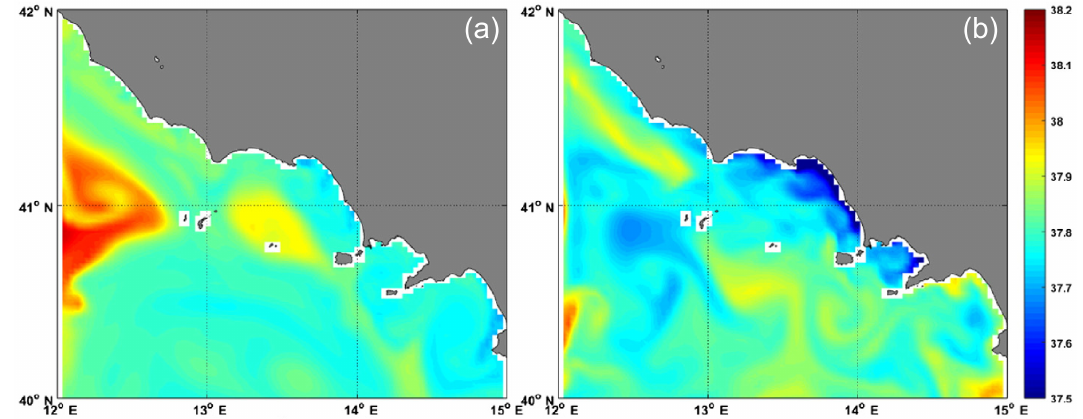
Figure 15. Surface salinity field (daily average) corresponding to 14 November 2010 without assimilation (a) and after assimilation (b) . From Fig. 1 in Santoki et al. (2013). Table 1. Summary of characteristics for the different methods. The latency of altimetric maps is taken to be 3 days, which corresponds to the intermediate map generated by SSALTO/DUACS system although preliminary data is available within 12h (AVISO Altimetry, 2016). The resolution and latency of wind-driven currents is taken from the characteristics of present scatterometer data. Technique